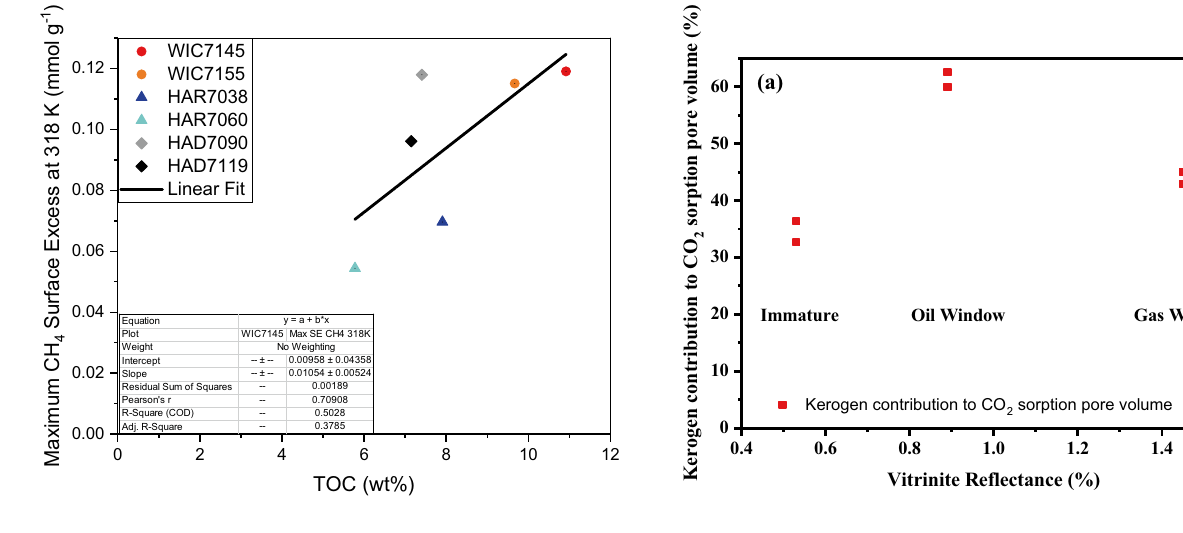
surface excess uptake at 4